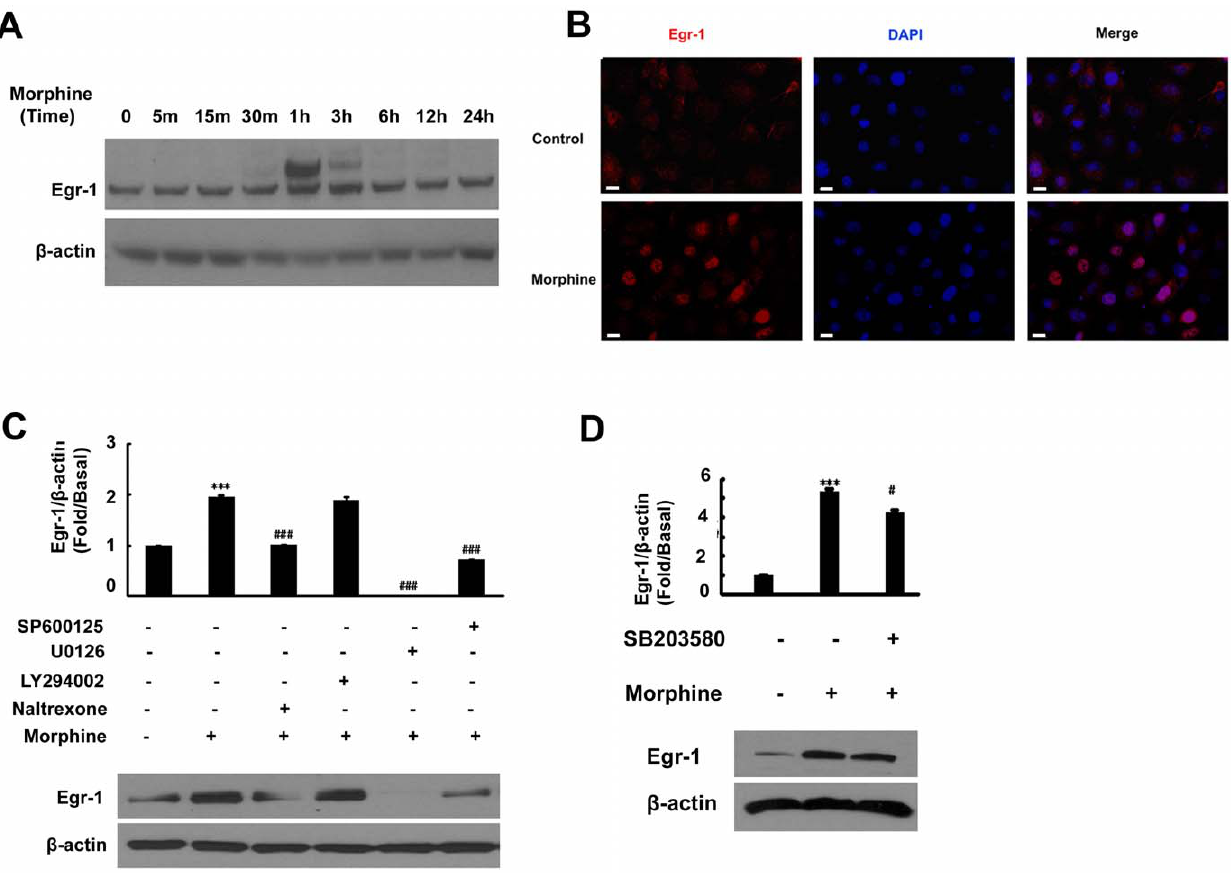
Figure 3. Egr-1 expression is up-regulated in HBMECs exposed to morphine. ( A ) Time-dependent activation of Egr-1 protein expression by morphine in HBMECs. ( B ) Representative image of Egr-1 staining in HBMECs treated with morphine. Scale bar=5 m m. Pretreatment of HBMECs with the inhibitors specific for Erk1/2-U0126 20 m M,JNK-SP600125 20 m M ( C ) and p38-SB203580 20 m M ( D ) but not Akt-LY294002 10 m M ( C ) pathways abrogates morphine-mediated induction of Egr-1. All the data are presented as mean 6 SD of three individual experiments. ***p , 0.001 vs control group; # p , 0.05, ### p , 0.001 vs morphine group.